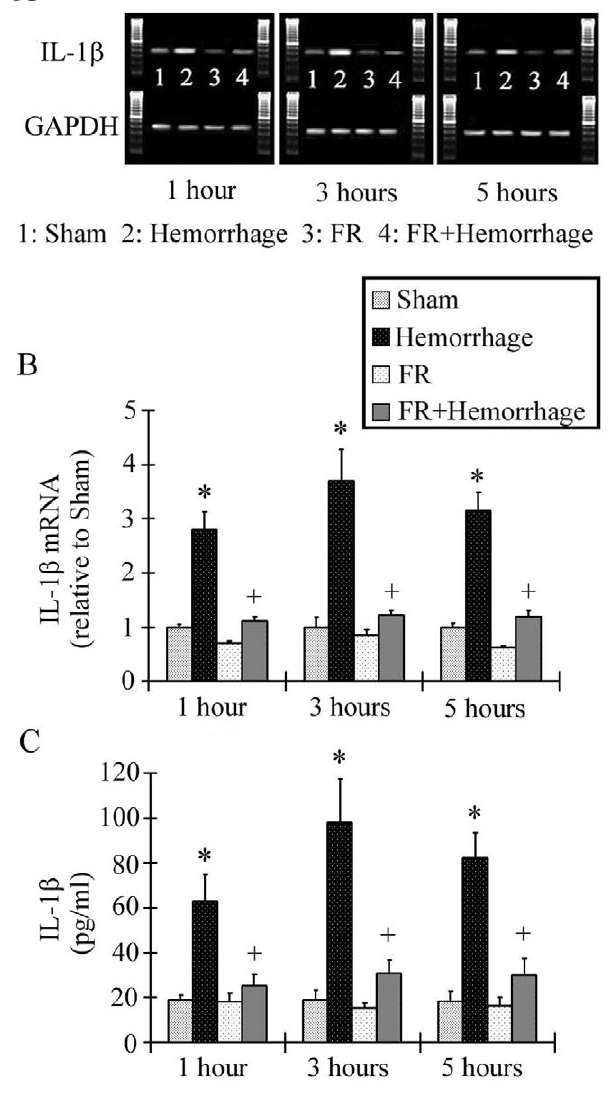
Figure 6. Changes in hepatic IL-1 b mRNA expression after hemorrhage. The IL-1 b mRNA level in the Hemorrhage group was highest at 3 hours post-hemorrhage, and was higher than that of the Sham group at all timepoints. On the contrary, the IL-1 b mRNA level in the FR + Hemorrhage group showed no change from baseline at any timepoint after hemorrhage. Similarly, the serum IL-1 b level in the Hemorrhage group was significantly increased from baseline at 3 hours after hemorrhage and then decreased over time, but was significantly higher than in the Sham group at all the timepoints post-hemorrhage as shown in C. In contrast, the serum IL-1 b level in the FR + Hemorrhage group showed no change from the baseline value throughout the experiment. Data are shown as mean 6 SE. n=5/groups, * p , 0.05 vs Sham, + p , 0.05 between Hemorrhage and FR + Hemorrhage.